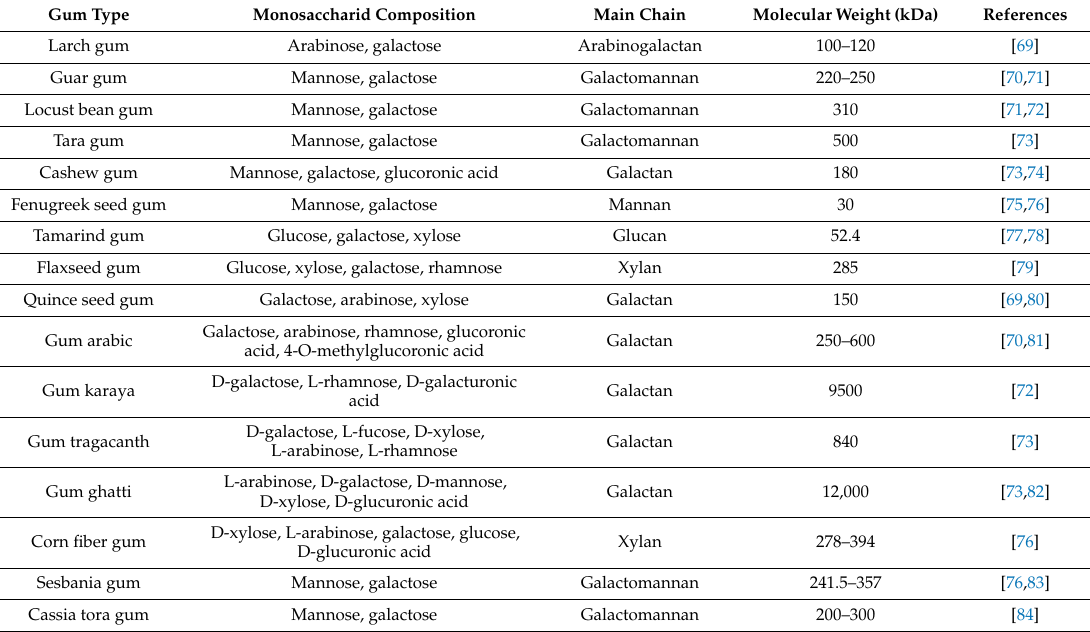
Table 1. Natural gums and their